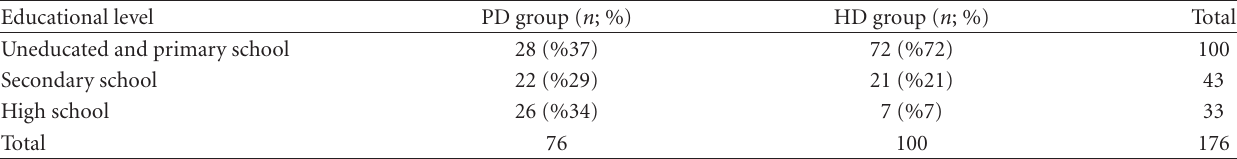
Table 2: Distribution of educational level in the PD ve HD groups . ( χ 2 test, P < .